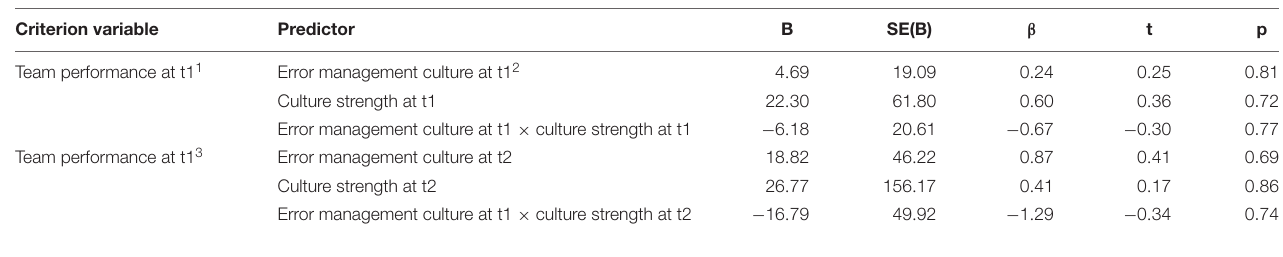
TABLE 4 | Moderation analysis for culture strength in Study